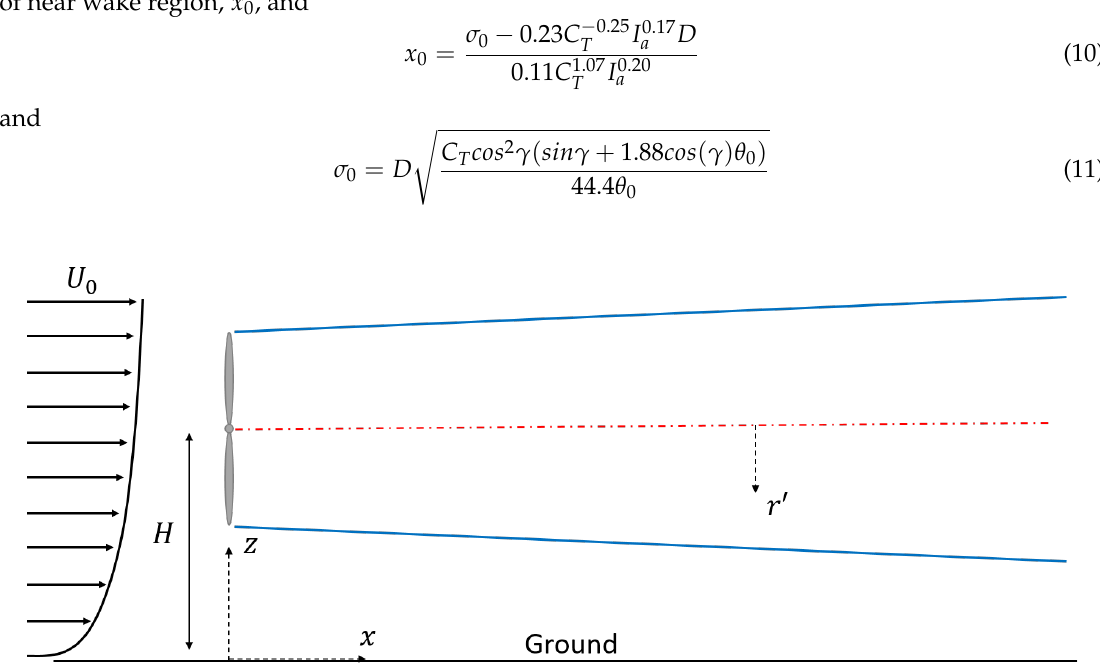
Figure 2. x − z plane of Gaussian wake as described by Qian and Ishihara